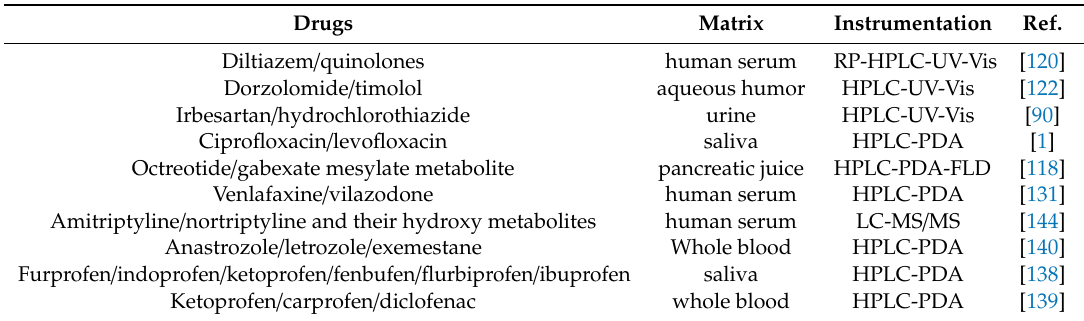
Table 7. Analytical procedures developed and validated for drug-association analyses in other biologic matrices.